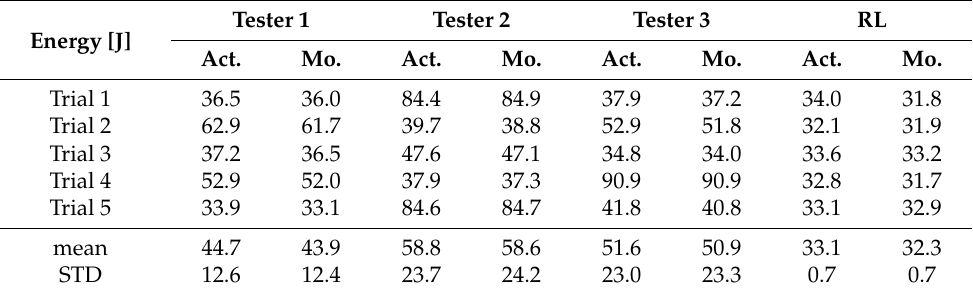
Table 4. The energy consumptions of the manipulator using human-taught and reinforcement learning (RL)-learned trajectories.